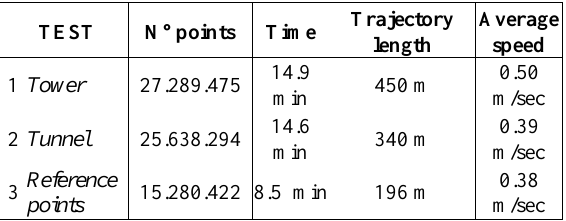
Table 2. San Vigilio SLAM-based datasets